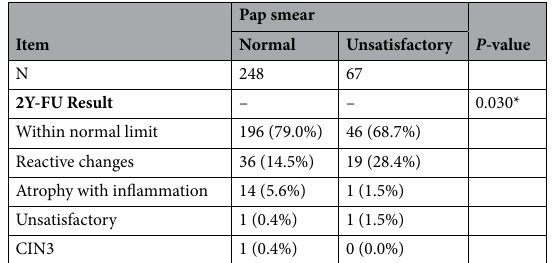
Table 4. Comparison of 2-year follow-up results ( n = 315). Data are presented as n or mean ± standard deviation. * p -value < 0.05 was considered statistically significant after test. CIN3: cervical intraepithelial neoplasia